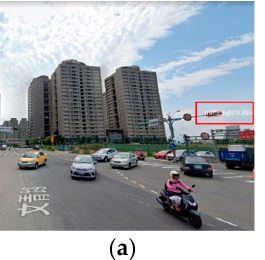
Figure 8. Recognition results from trained models: ( a ) without data augmentation; ( b ) with data augmentation.